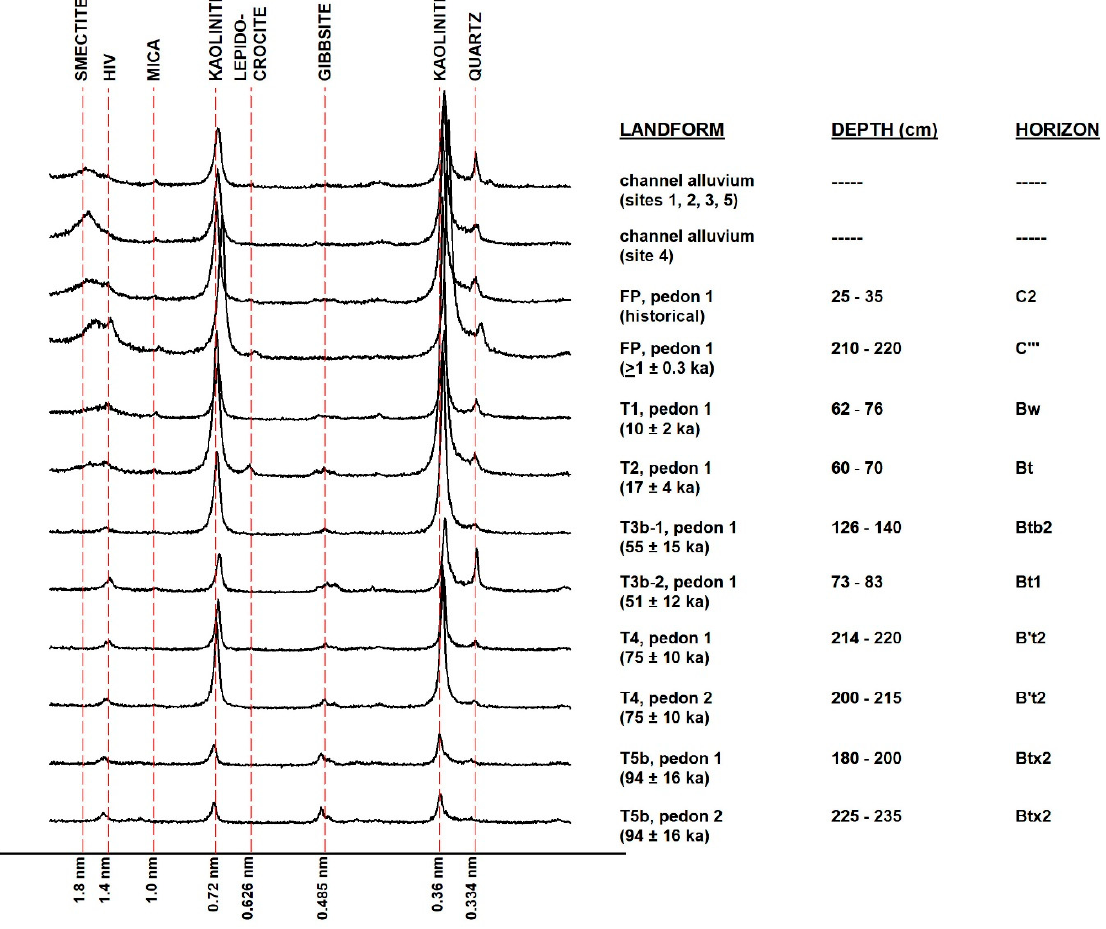
Table 3. Percentages of clay fraction (<2 µm) gibbsite and kaolinite determined by differential scan- ning calorimetry (DSC) for channel bed sediment and the most well-developed subsoil horizon of at least one representative pedon per landform from the Little River valley.